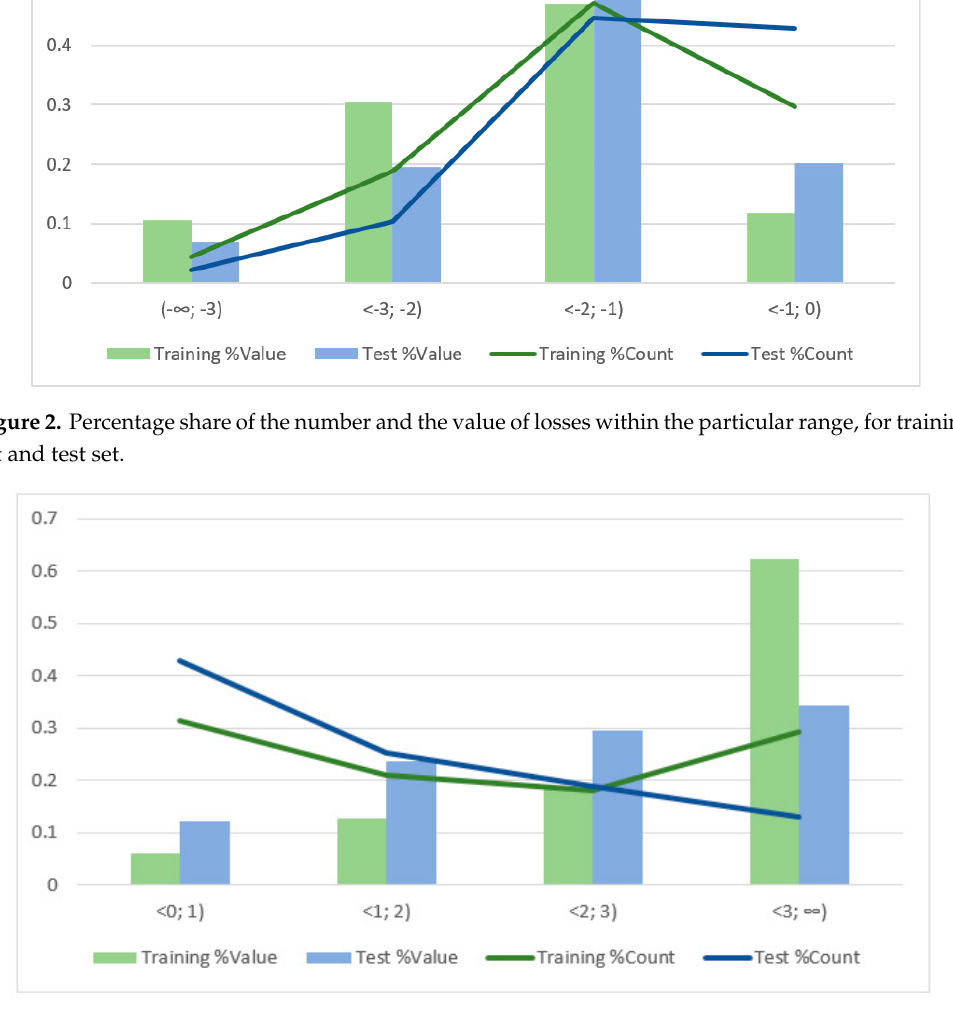
Figure 3. Percentage share of the number and the value of profit within the particular range, for training set and test set.